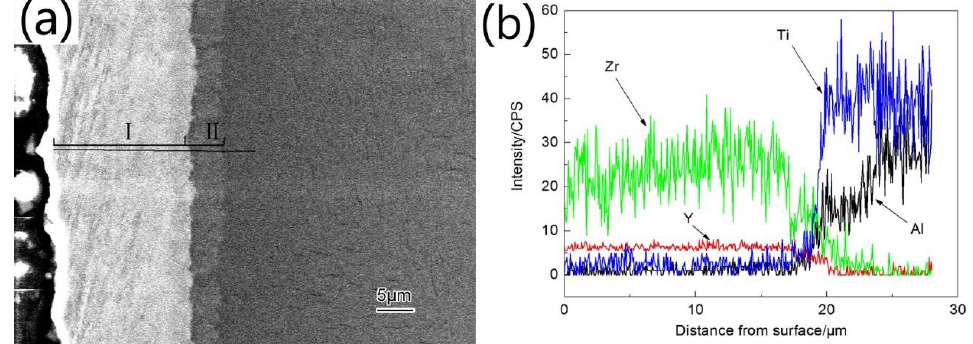
Figure 3. Component distribution of the Zr-Y coating: ( a ) cross-section; ( b ) EDS.